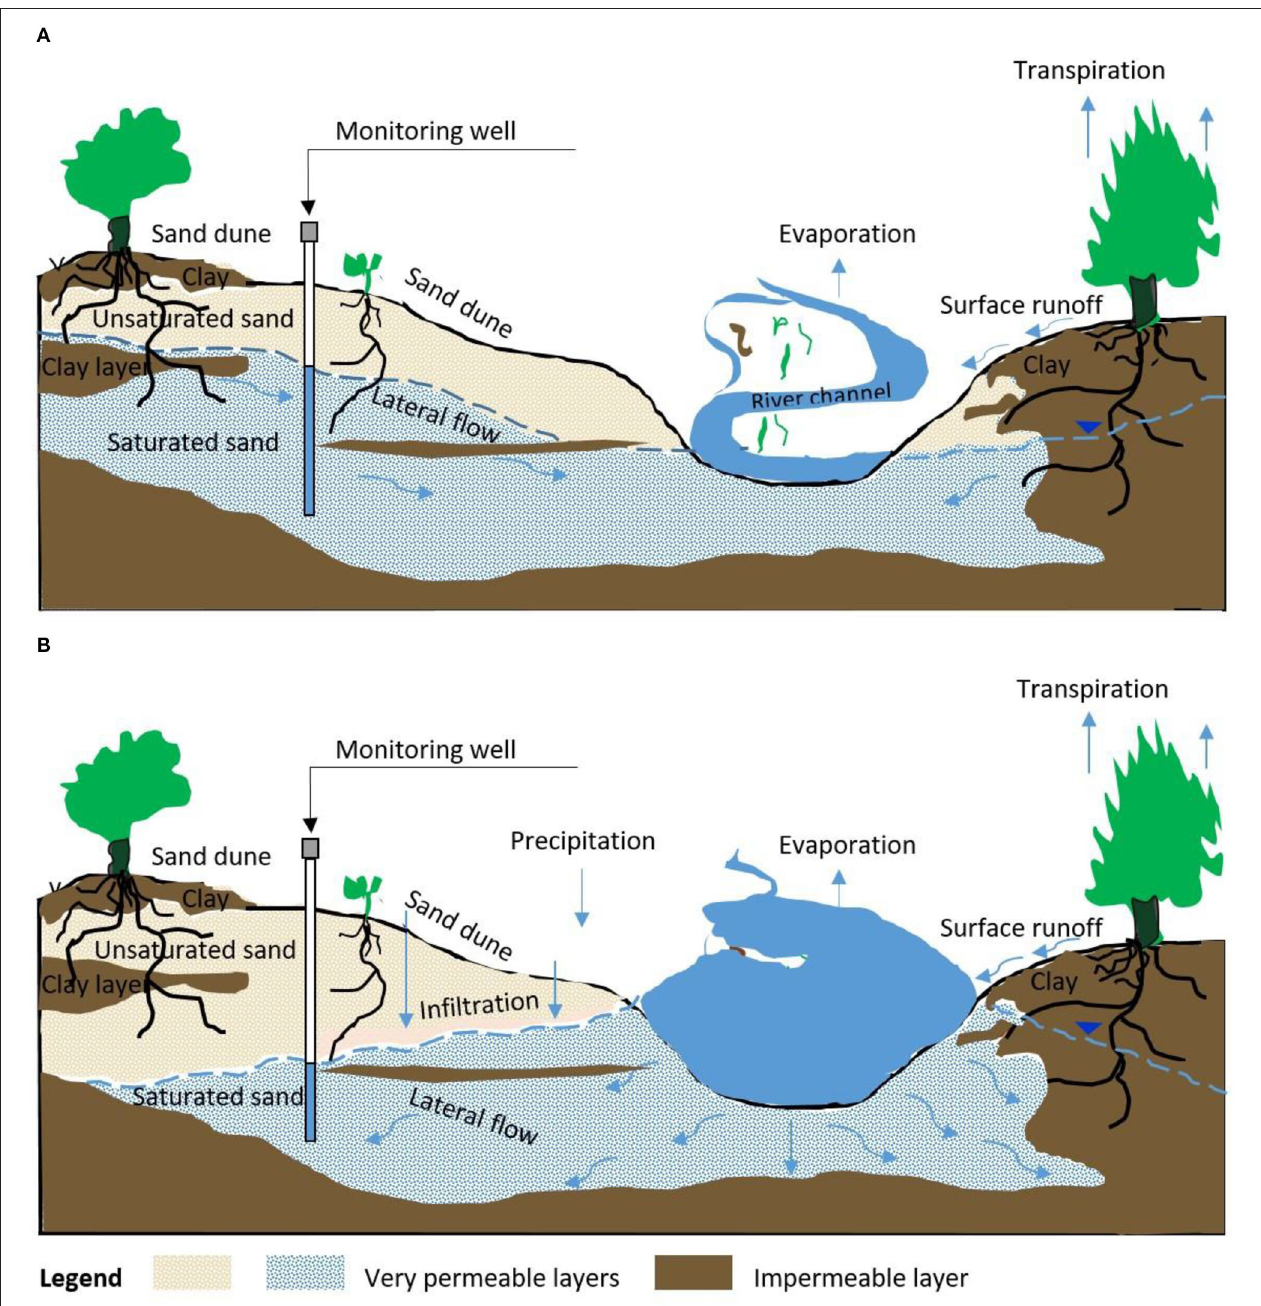
FIGURE 13 | 2D schematic cross section representing the conceptual model of the sand river aquifer system and the respective hydrological processes. (A) Dry season, (B) flooding season.